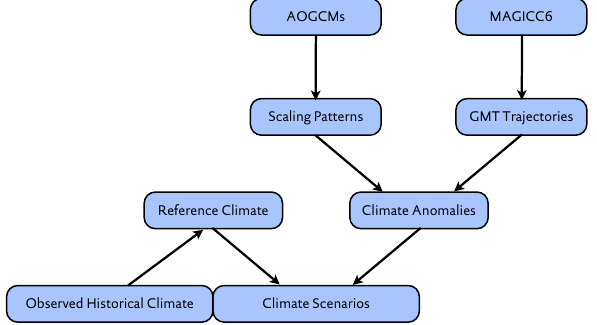
Fig. 1. Flow chart of data processing for the generation of climate scenarios.